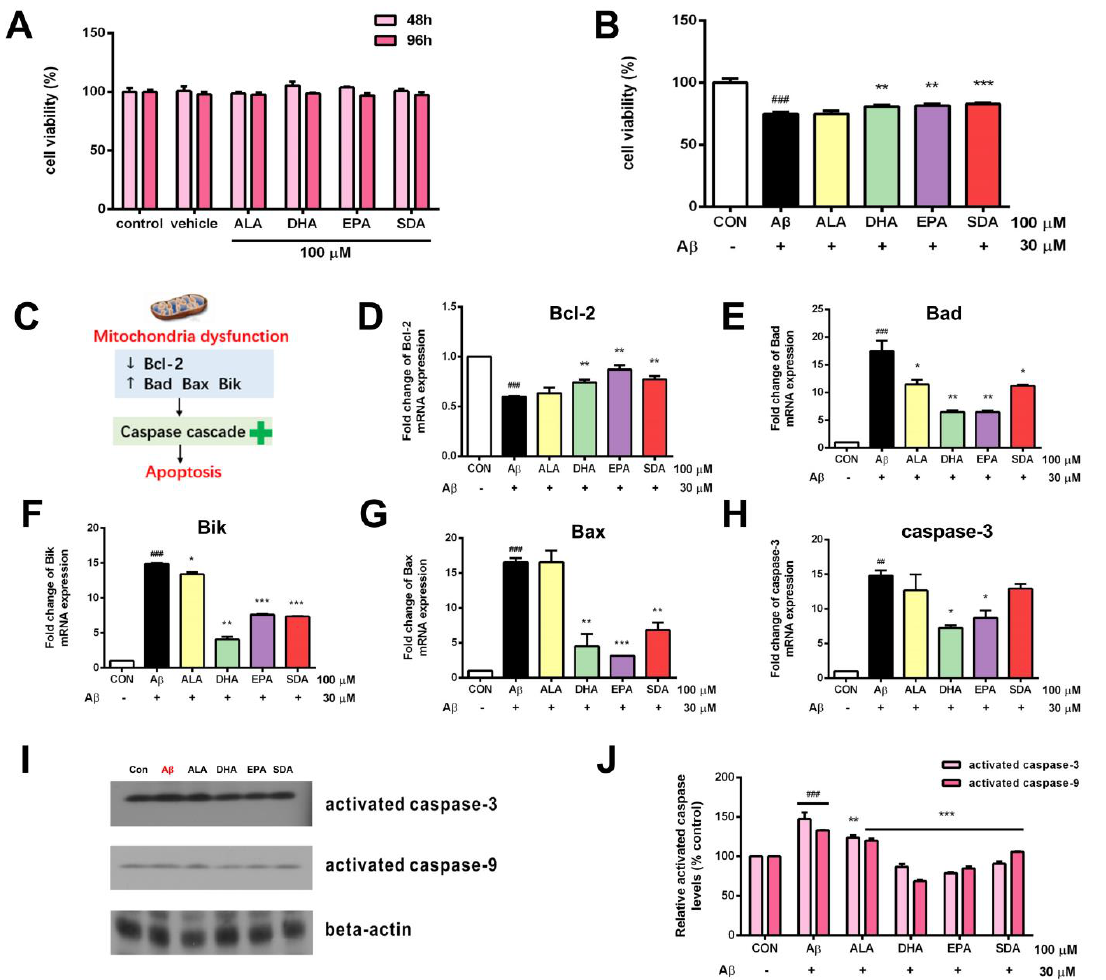
Figure 3. SDA protects against Aβ -induced hippocampal cell death. ( A ) The viability of H19-7 cells after treatment with ALA, DHA, EPA, SDA, or BSA – ethanol (vehicle) in the concentration of 100 μM for 48 h or 96 h. ( B ) The viability of H19-7 cells after 48 h of culture in medium enriched with ALA, DHA, EPA, SDA prior to exposure to non-fibrillar Aβ for 24 h. ( C ) Aβ strongly decreased anti-apoptotic gene Bcl-2 expression and increased the expression of pro-apoptotic genes, caspase-3, Bad, Bax, and Bik. H19-7 cells were pretreated with ALA, DHA, EPA, SDA, or BS – ethanol vehicle control in the concentration of 100 μM for 48 h, then 30 μM Aβ1 -40 was added into the medium for another 24 h incubation. The mRNA expression of anti-apoptotic gene ( D ) Bcl-2 and pro-apoptotic gene ( E ) Bad, ( F ) Bik, ( G ) Bax, and ( H ) caspase-3 in H19-7 cells. ( I , J ) The protein expression of the activated caspase-3 and activated caspase-9 in H19-7 cells. Values were obtained from three independent exper- iments and were expressed as the means ± SEM; ## p < 0.01, ### p < 0.001, different from BSA – ethanol vehicle-treated control cells; * p < 0.05, ** p < 0.01, *** p < 0.001, different from Aβ1 -40-treated cells.